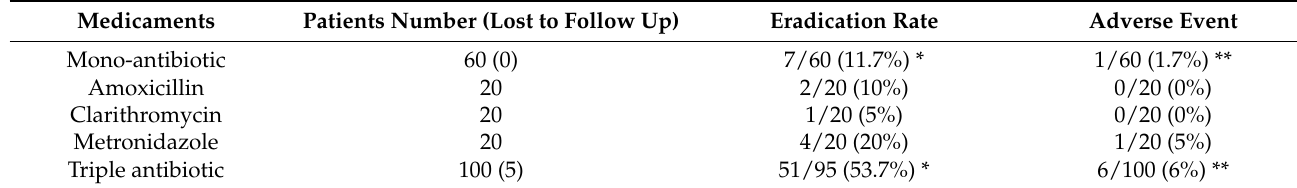
Table 3. Medicaments affecting the efficacy and adverse event of ILTHPI.